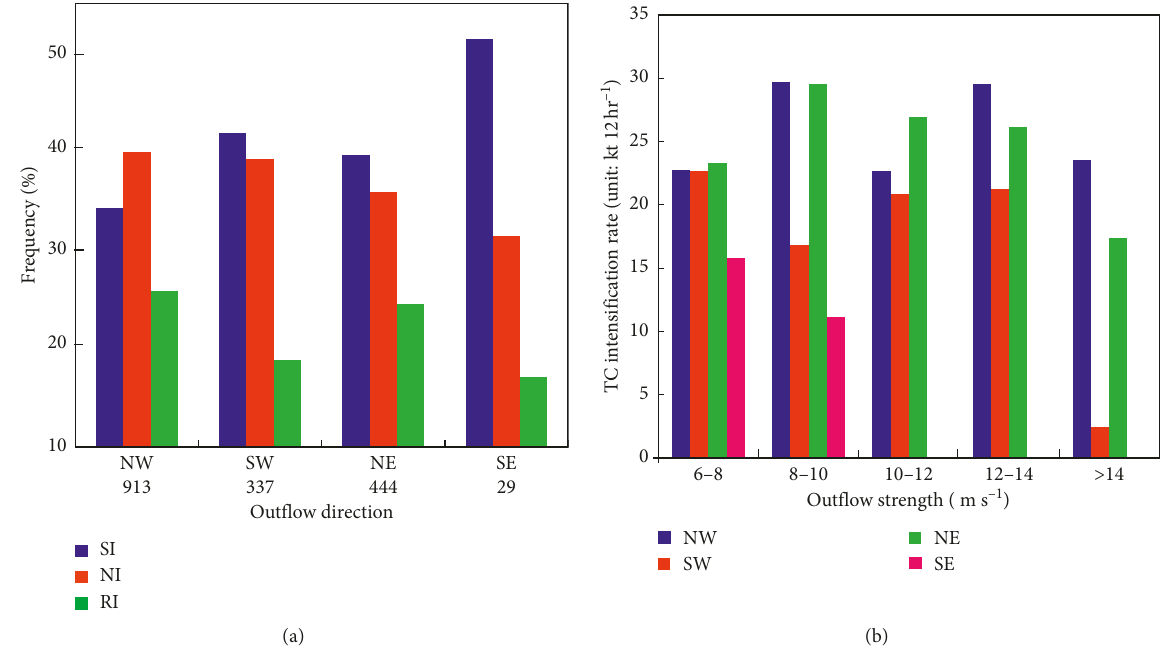
Figure 12: (a) The frequency of RI, NI, and SI in four outflow directions. The number of the below direction is the total number of the cases for each single outflow direction. (b) The average intensification rate for 12 hr of the four outflow directions in each single outflow strength bin (m s − 1 ). NW, NE, SE, SW is northwest, northeast, southeast, and southwest, respectively.